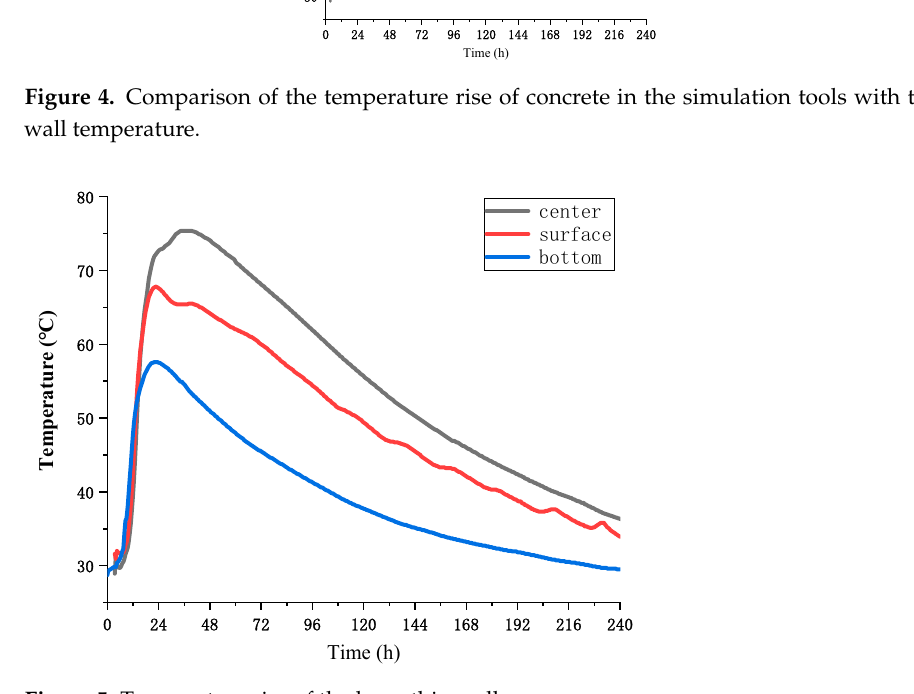
Figure 5. Temperature rise of the large thin wall.